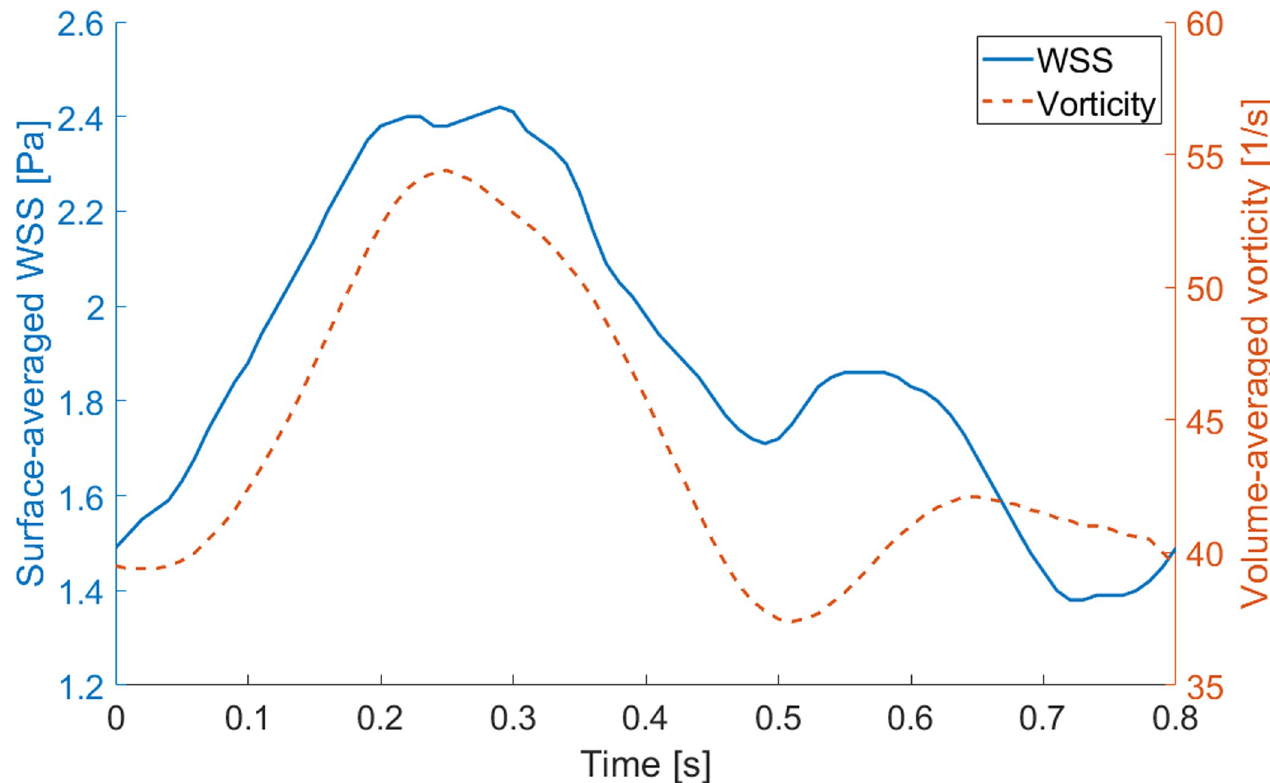
Fig 12. Time evolution of spatially averaged WSS and volume-averaged vorticity (generated with data from S11 File).